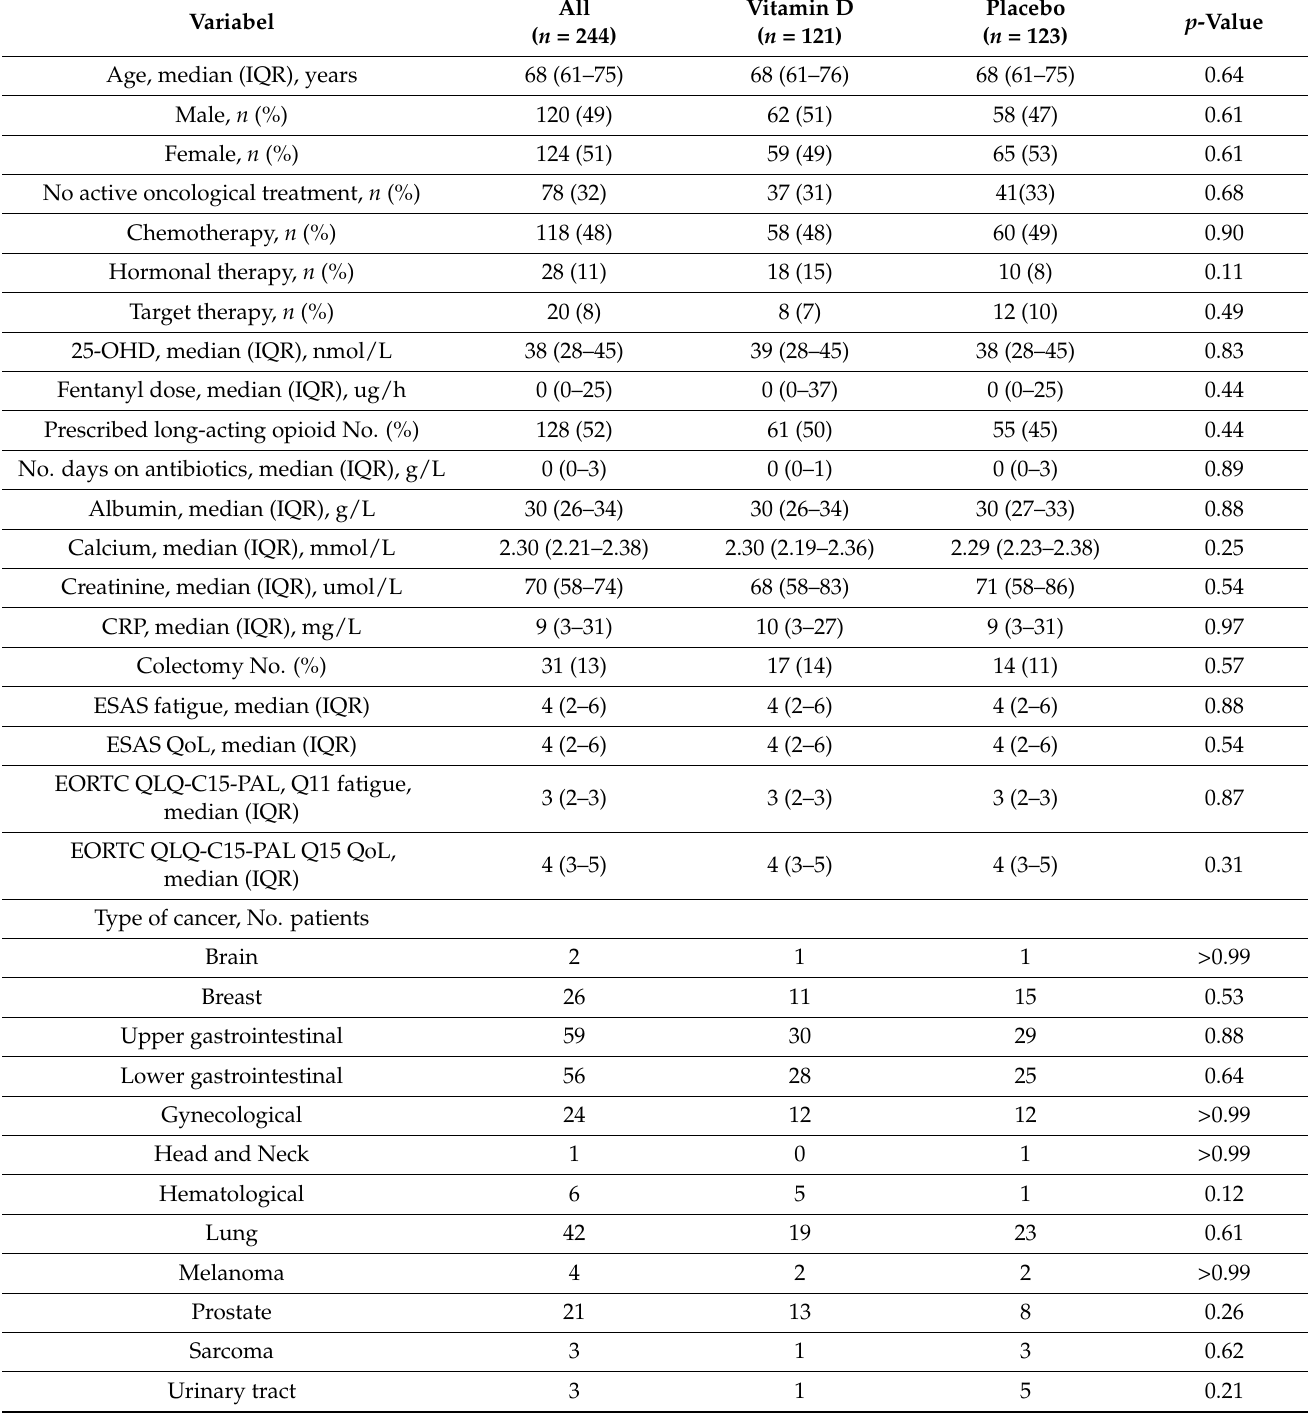
Table 1. Baseline characteristics of randomized patients in the ‘Palliative-D’